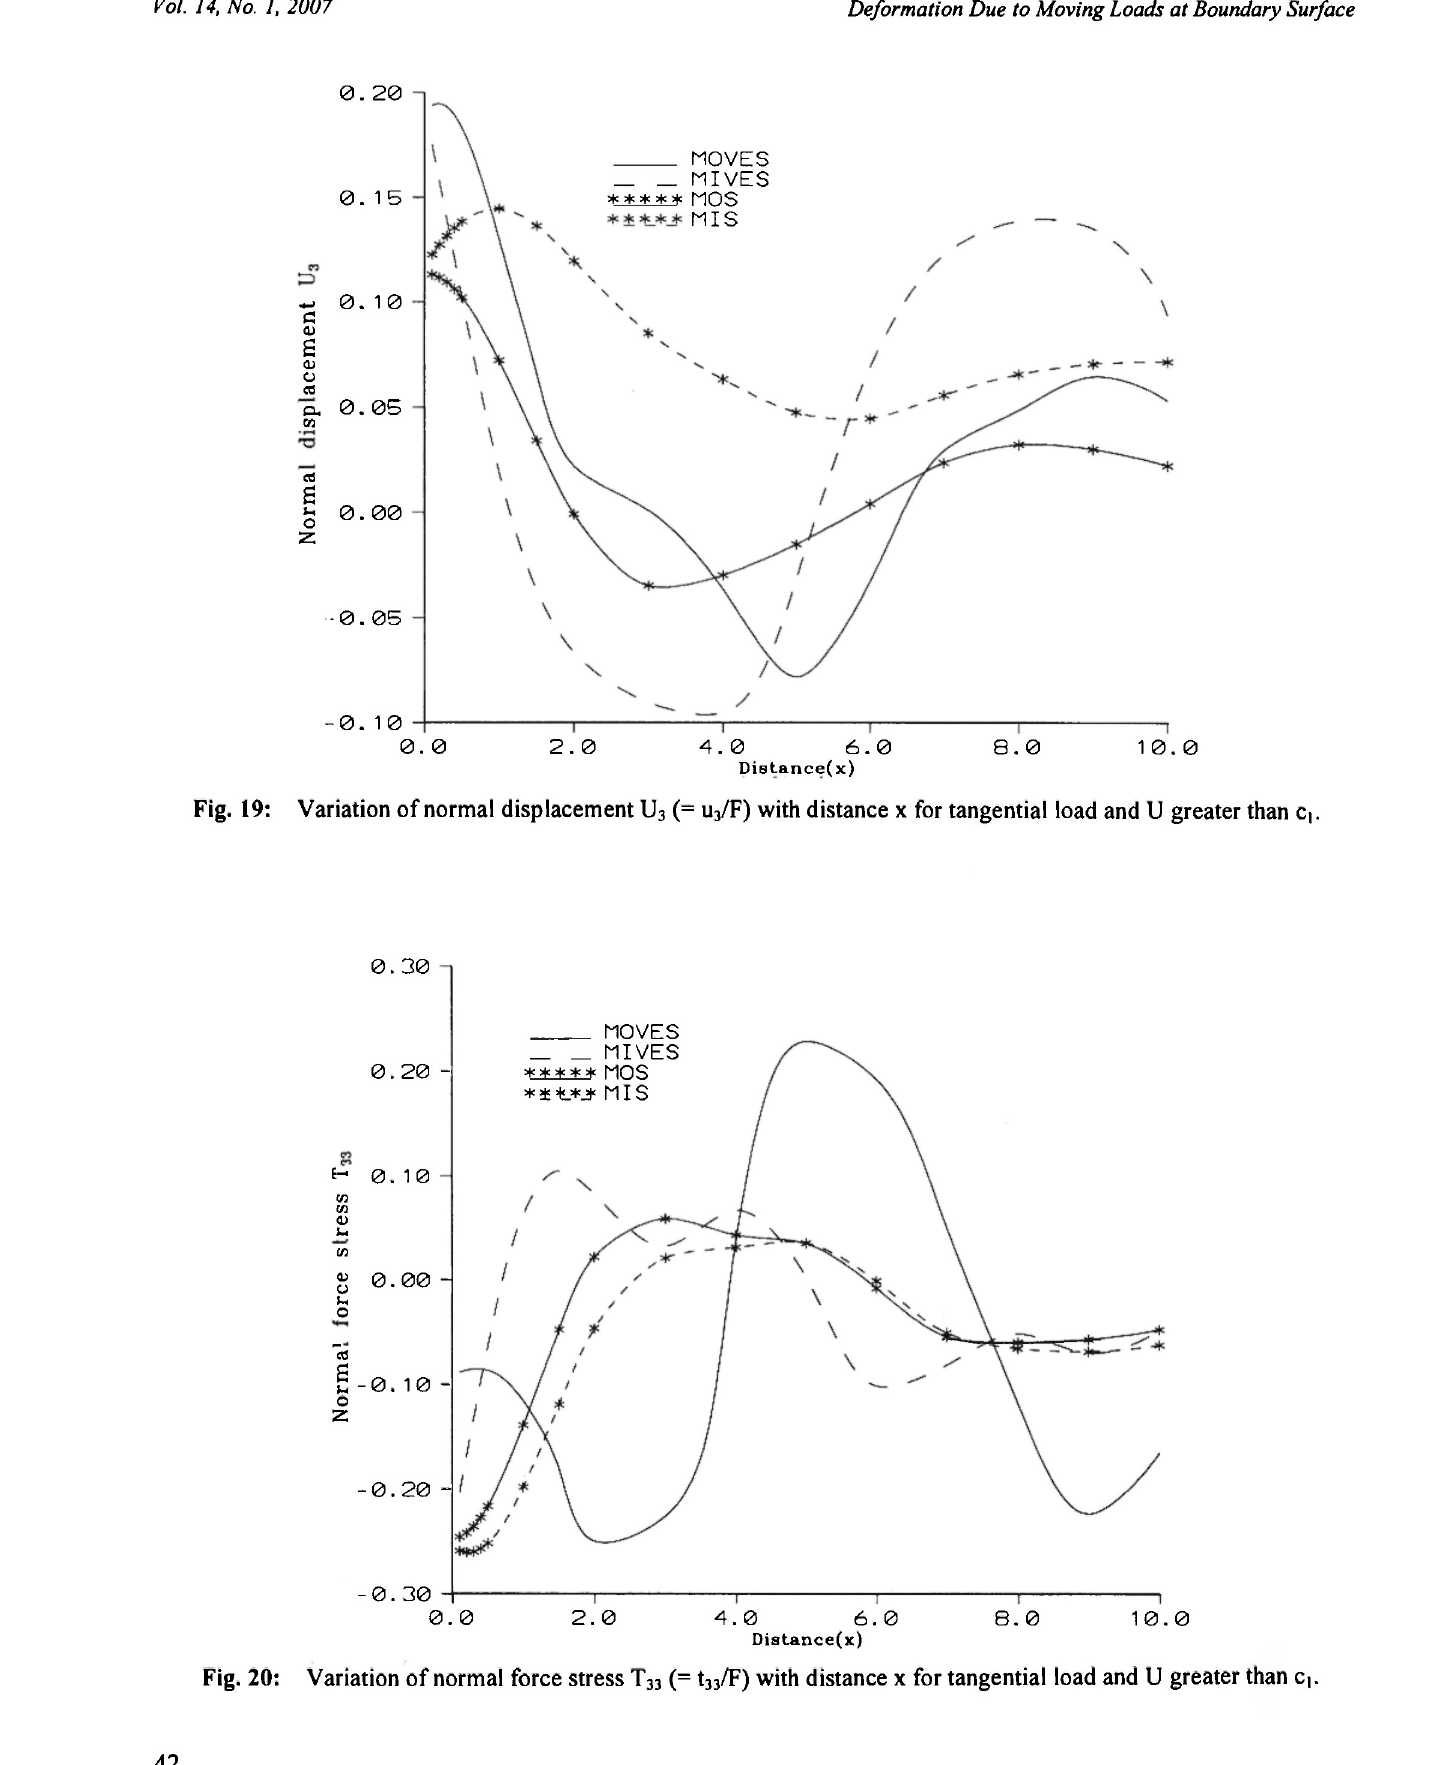
Variation of normal force stress T 33 (= t 33 /F) with distance χ for tangential load and U greater than